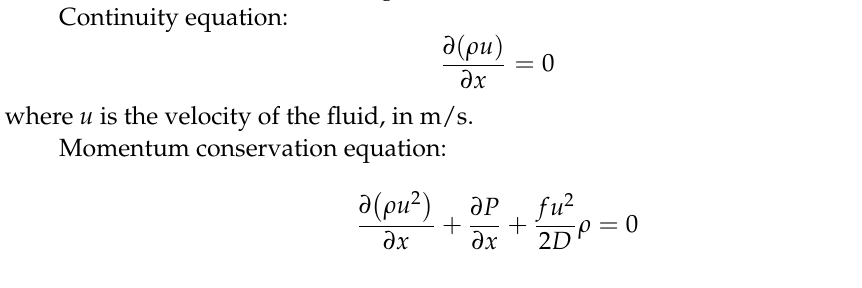
Figure 2. The thermal property parameters of molten salt and sCO 2.